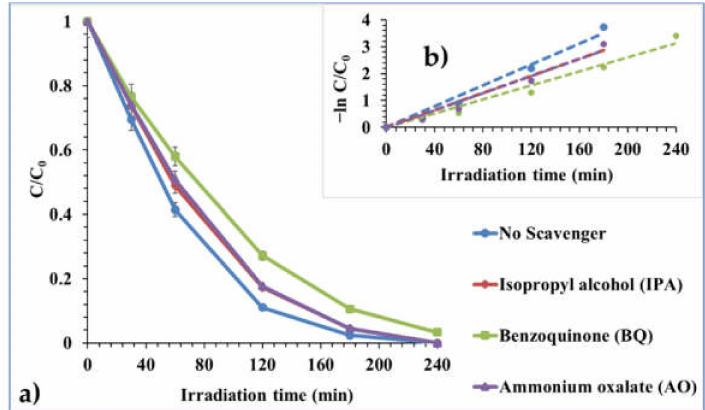
Figure 13. ( a ) Chemical scavenger effect on the photocatalytic degradation performance of 1 g/L Mo/SynTiO 2 over 5 mg/L initial CBZ concentration under natural (unmodified) pH 5.84, and 365 nm irradiation; and ( b ) their corresponding photocatalytic degradation rate constant